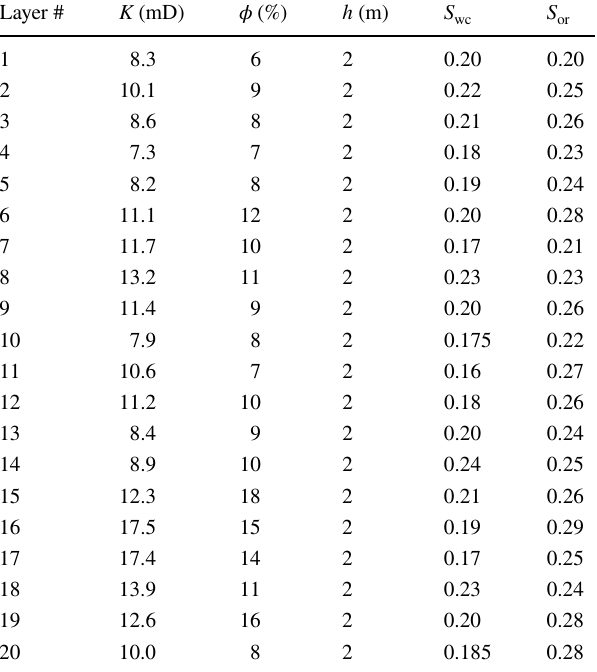
Table 1 Characteristics used for the reservoir stratigraphic layers